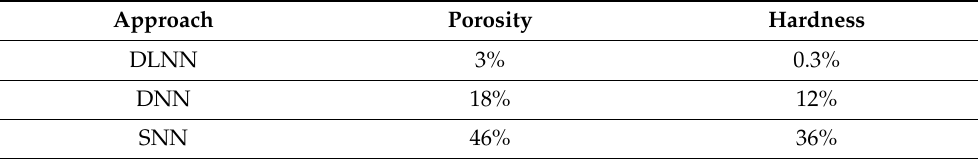
Table 3. Mean percentage error comparison for tested